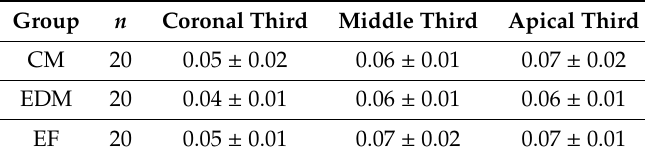
Table 2. Root canal transportation after use of the thermally-treated instrument systems (mm ± SD).